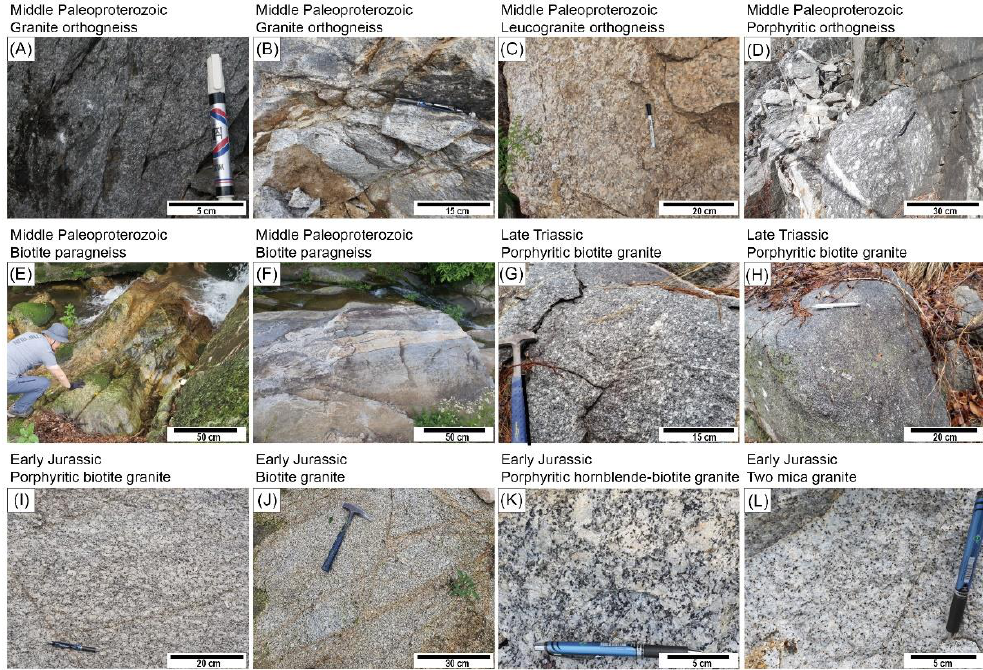
Figure 3. Outcrop photographs showing ( A , B ) Middle Paleoproterozoic granite orthogneiss with magmatic flow structure, ( C ) Middle Paleoproterozoic leucogranite orthogneiss, ( D ) Middle Paleoproterozoic K-feldspar megacryst-bearing porphyritic orthogneiss, ( E , F ) Middle Paleoproterozoic banded biotite paragneiss having alternation of biotite paragneiss and granite orthogneiss, ( G , H ) Late Triassic biotite granite with textures commonly characterized by K-feldspar megacrysts, ( I , J ) Early Jurassic porphyritic biotite granite, ( K ) hornblende-biotite granite with or without K-feldspar megacrysts, and ( L ) Early Jurassic two-mica granite in the Jangsu-gun area.